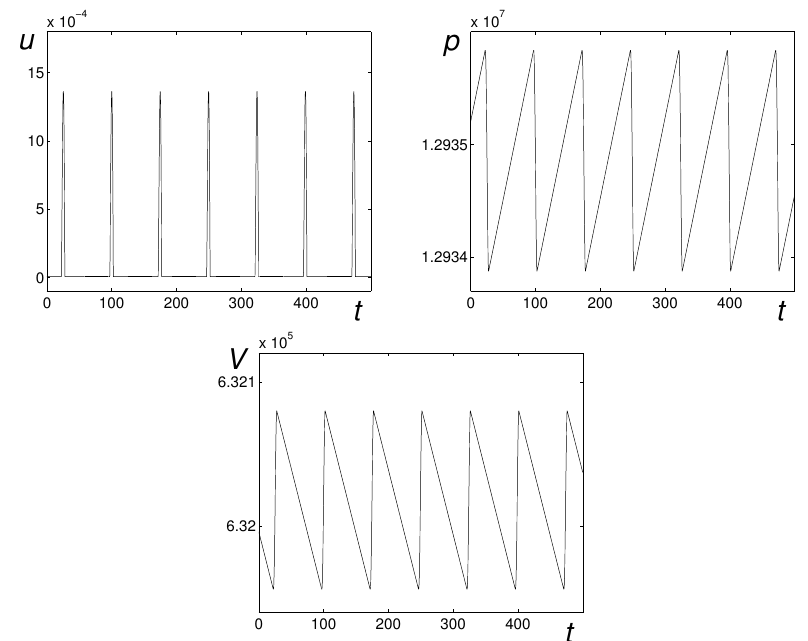
Figure 3. Time series of the cycle shown in Fig. 2: u (ms − 1 ), p (Pa) and V (m 3 ) as functions of time t (s). by a function (Iverson et al.,